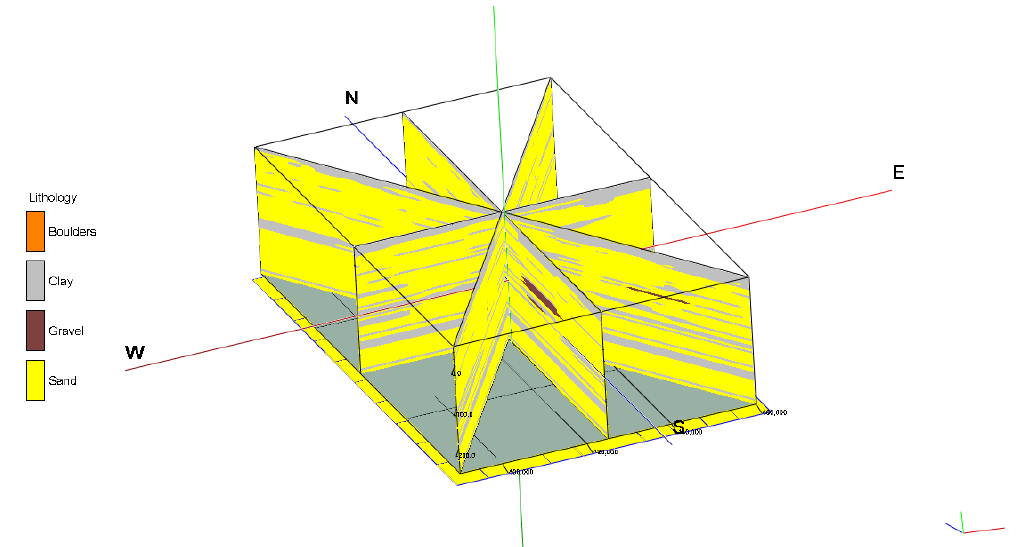
Figure 2. Fence diagram of the subsurface for the section lines shown in Figure 1.